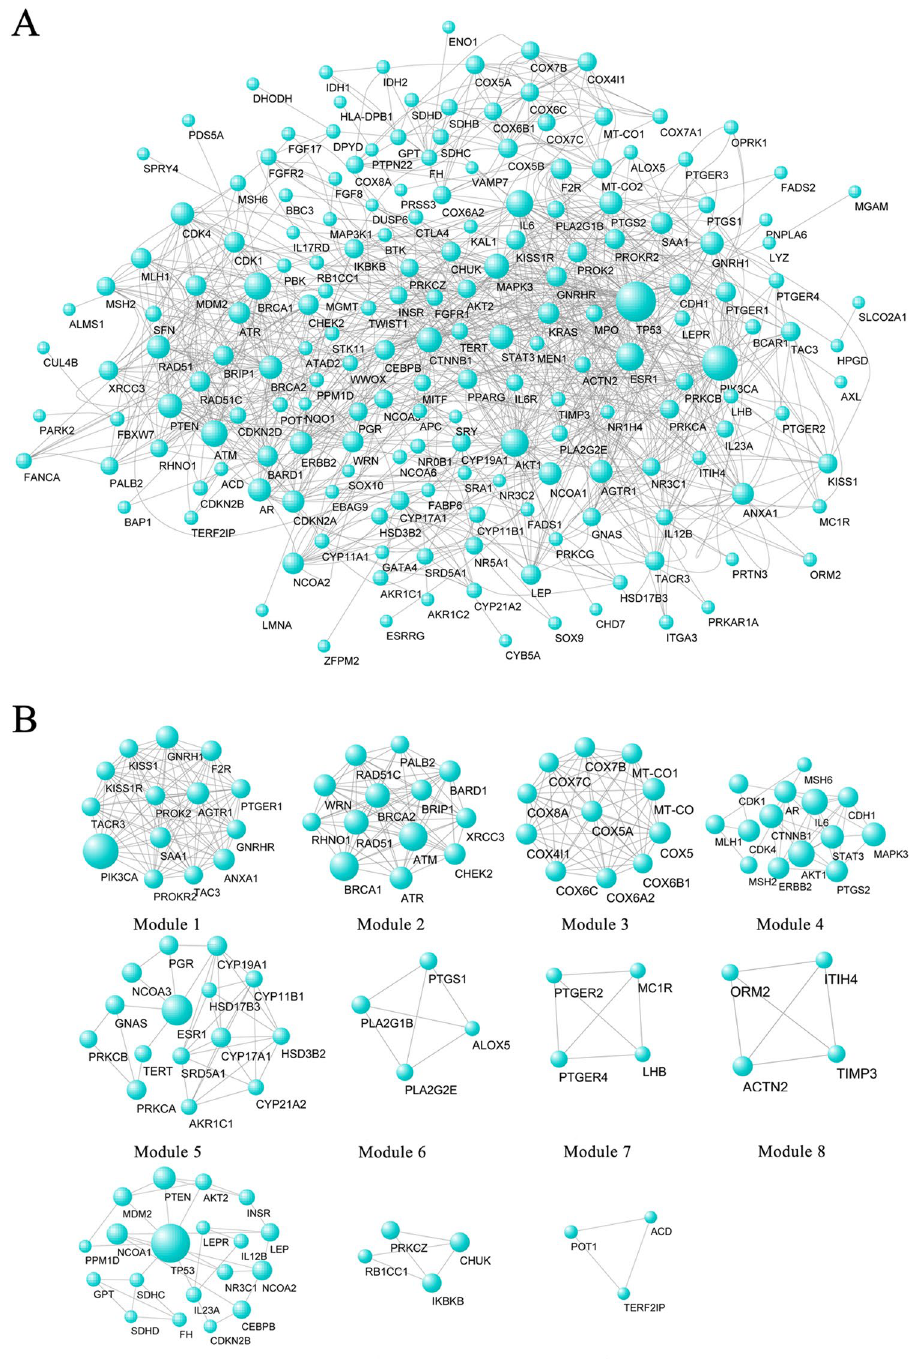
Figure 4. ( A ) The protein interaction network of Pro, Bet and Lev; ( B ) the modules of the protein interaction network of Pro, Bet and